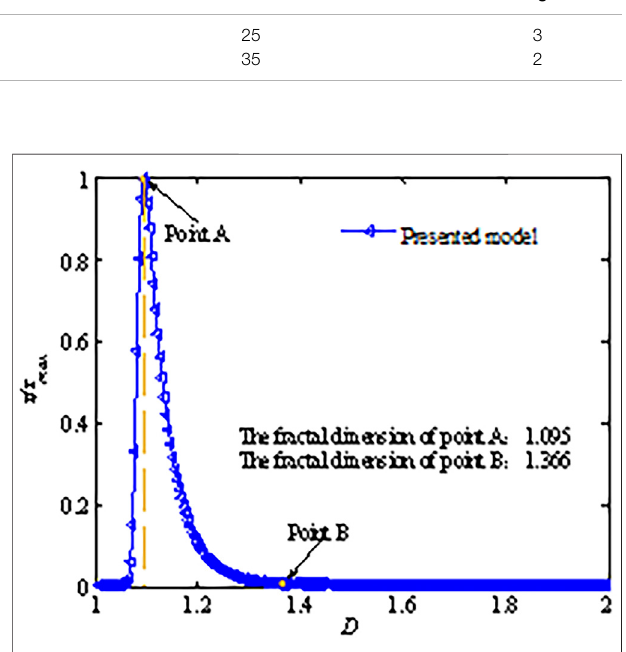
FIGURE 6 | Veri fi cation diagram of the relationship between the shear strength and the fractal dimension.